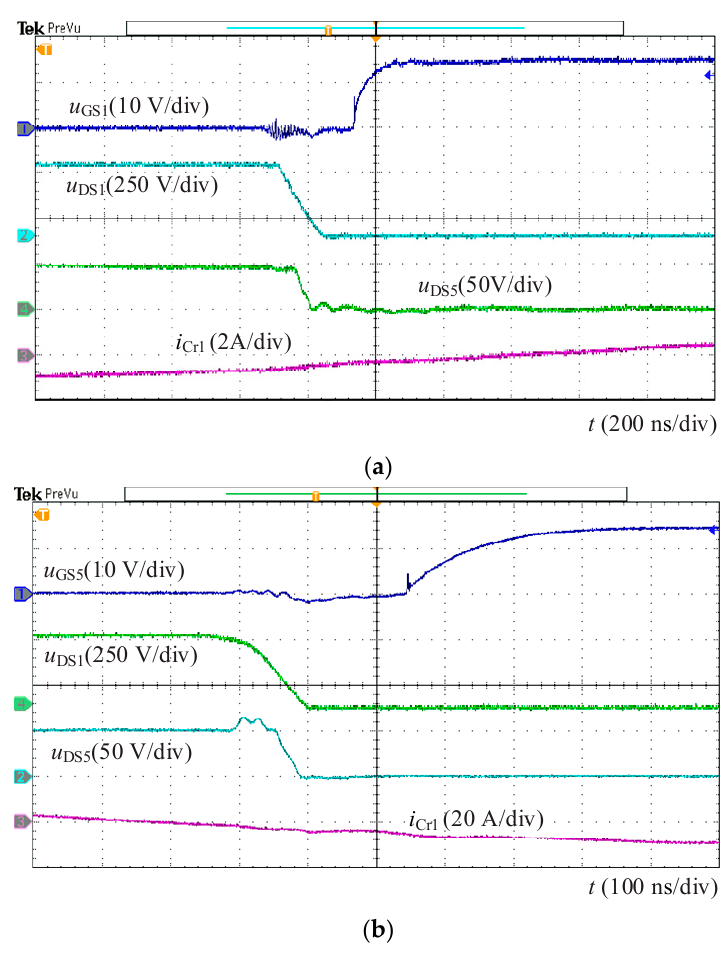
Figure 14. Experimental results of ZVS: ( a ) forward mode, 500 W; ( b ) backward mode, 5 kW.